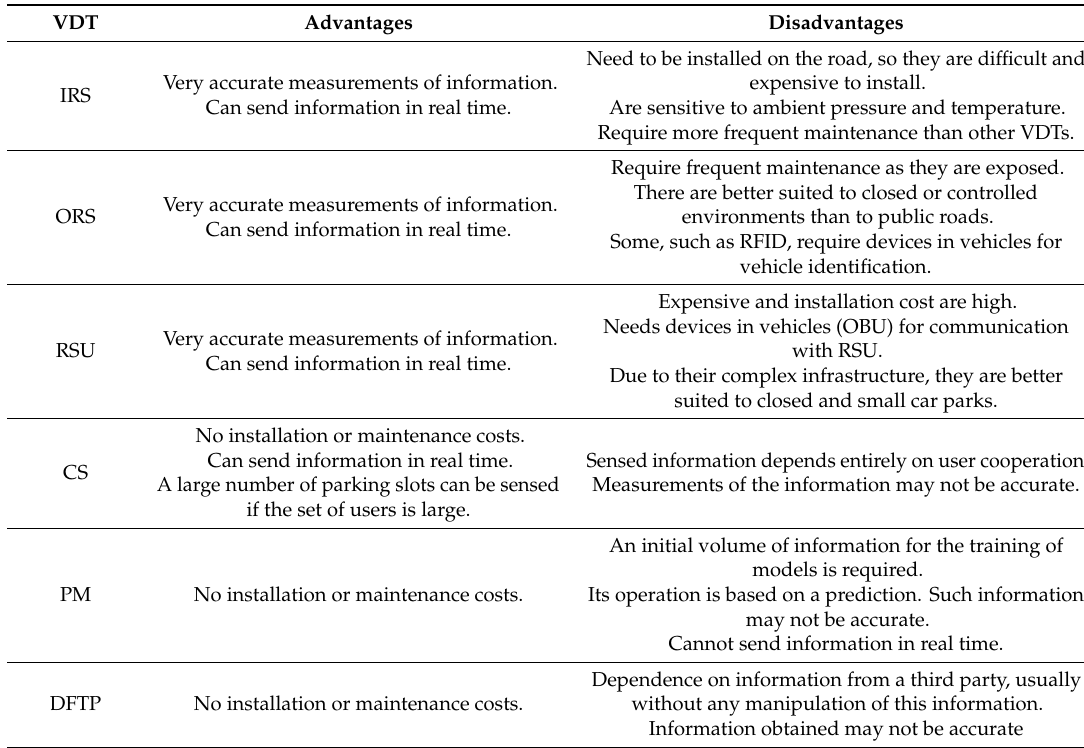
Table 10. VDT principal advantages and disadvantages.